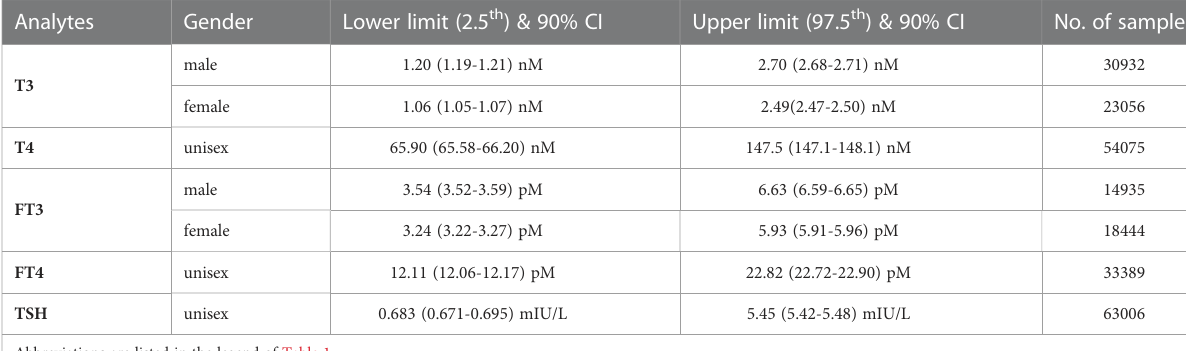
TABLE 4 The RIs (95% CI) for T3, T4, FT3, FT4, and TSH.